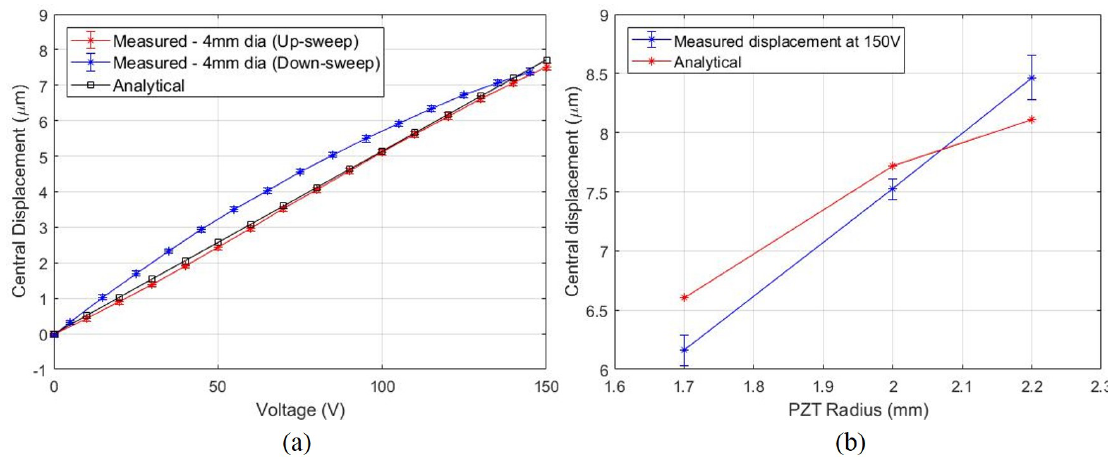
Figure 7. ( a ) Comparison of measured and predicted displacement for a 4mm diameter actuator in the unimorph piezoelectric microactuator (UPM) holder. ( b ) Displacement of different actuators at 150V. The predicted displacements are plotted for comparison. Error bars indicate one standard deviation of three measurements in each sample for both graphs.